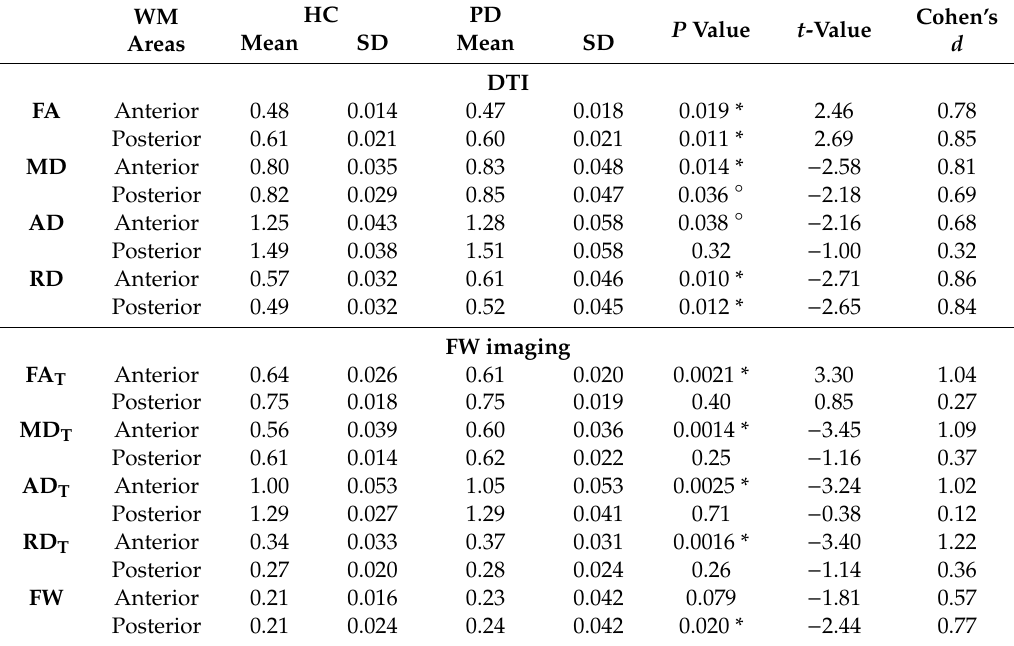
Figure 2. Comparison of FW imaging (MD T , AD T , and FW) indices between the healthy controls and the patients with PD. GBSS analyses showed that the patients with PD had significantly higher MD T , AD T , and FW (red-yellow voxels) compared with the healthy controls ( p < 0.05, FWE-corrected). The skeleton is presented in green. To aid visualization, the results are thickened using the fill script implemented in the FMRIB Software Library. AD, axial diffusivity; AD T , FW-corrected axial diffusivity; FW, free water; GBSS, gray matter-based spatial statistics; MD, mean diffusivity; MD T , FW-corrected mean diffusivity; PD, Parkinson’s disease. Table 3. Region-of-interest analysis of diffusion tensor and free-water imaging indices in the white matter of Parkinson’s disease patients and healthy controls.